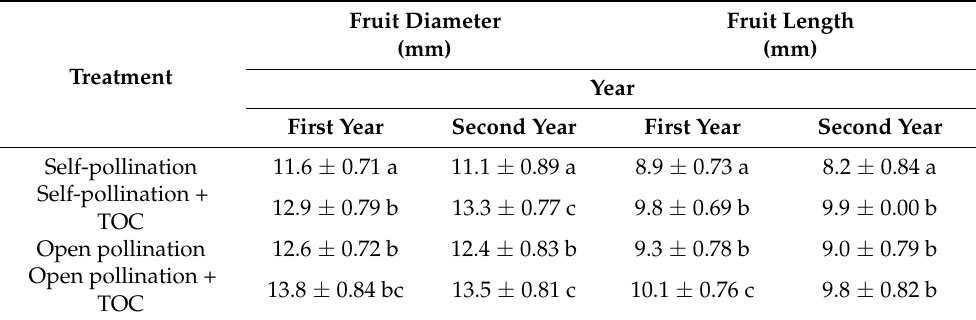
Table 4. The effect of experimental factors: type of pollination and application of titanium organic complex (TOC) on the diameter and length of individual blueberry fruit